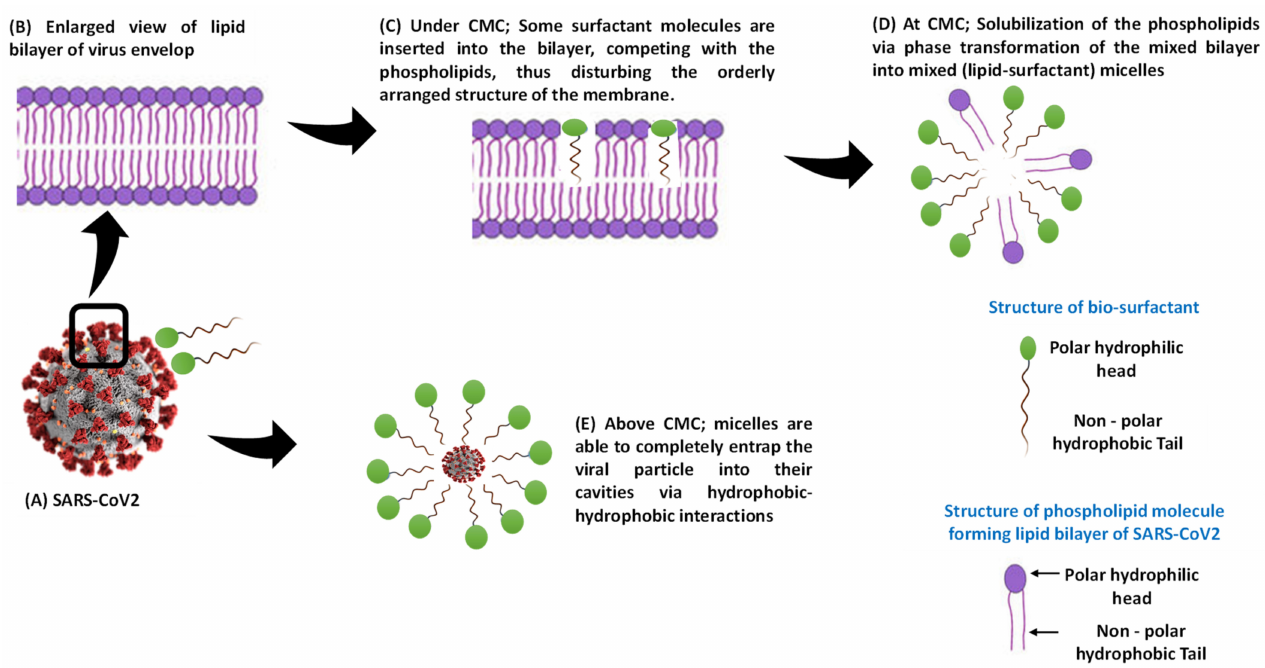
Figure 9. Sketch presenting the inactivation of SARS-CoV-2 by biosurfactants as a single molecules and